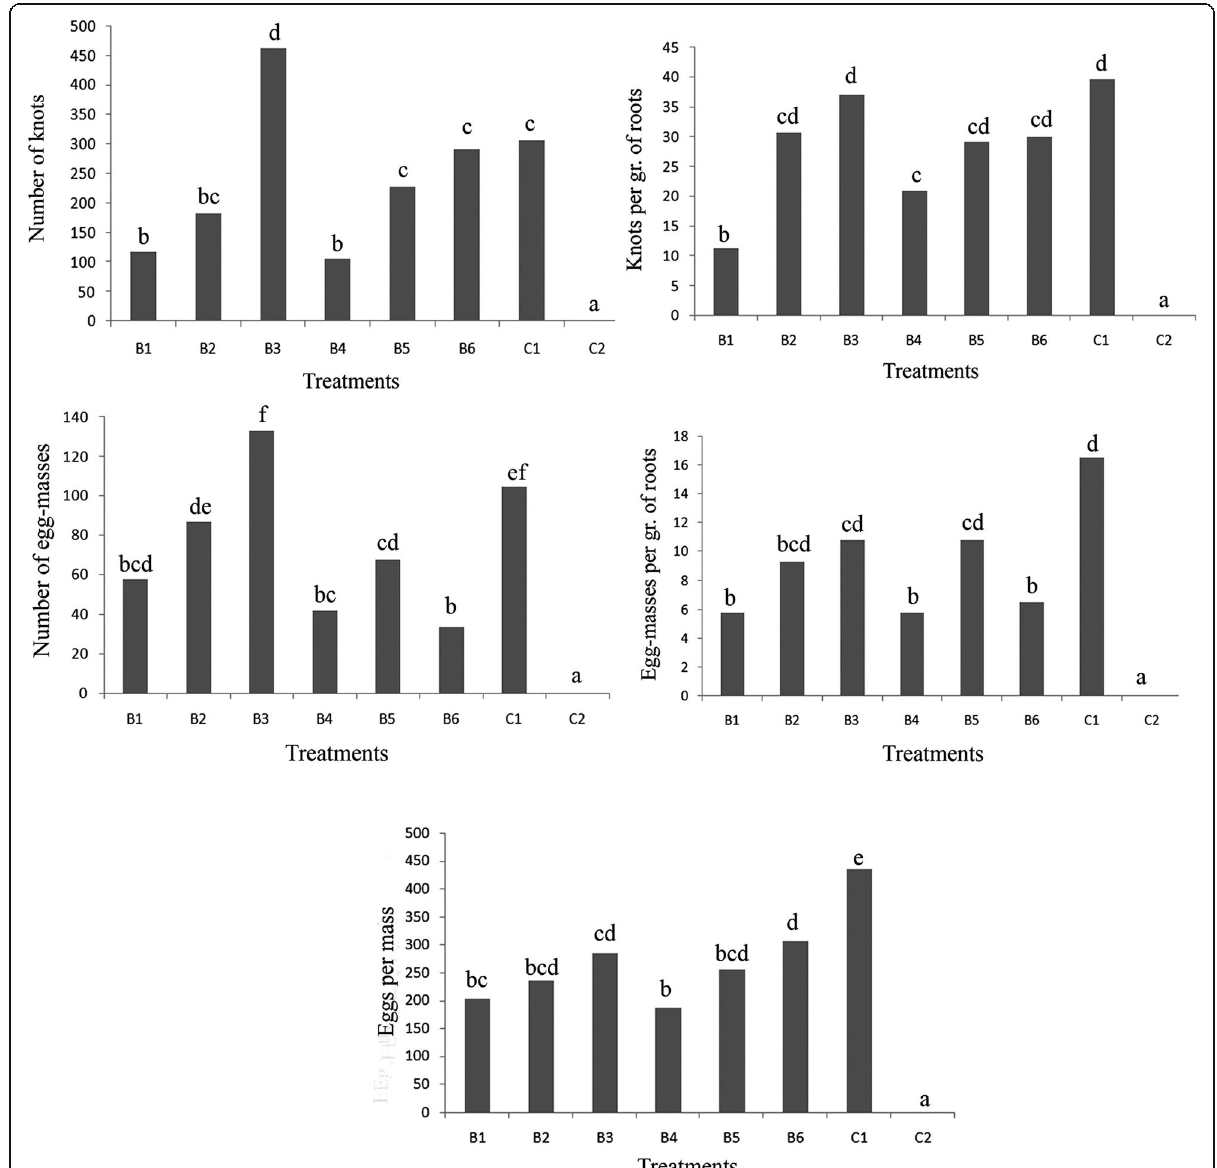
Fig. 4. Mean comparisons of nematode reproductive parameters in treatments. B 1 ( Bacillus wiedmannii + nematode), B 2 ( Pseudomonas thivervalensis + nematode),